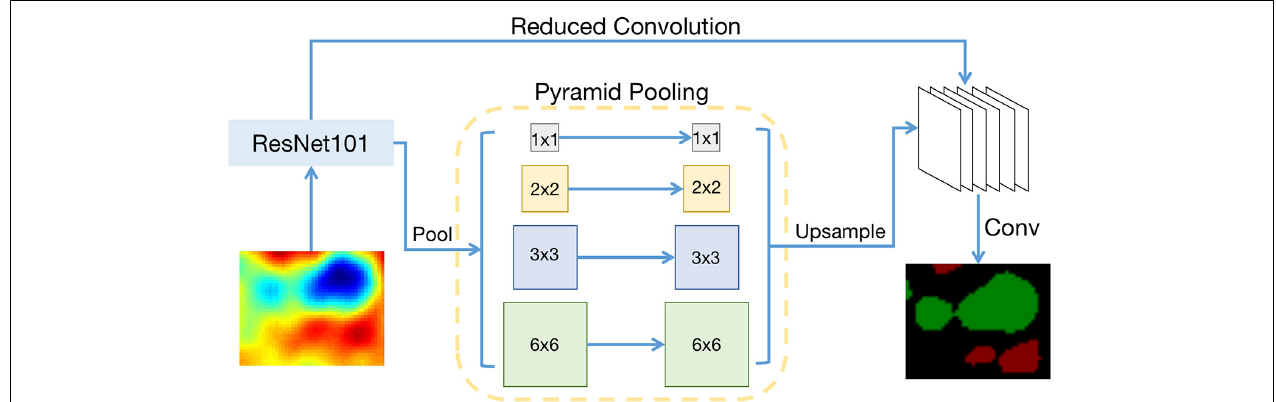
FIGURE 1 | Schematic diagram of PSPNet.